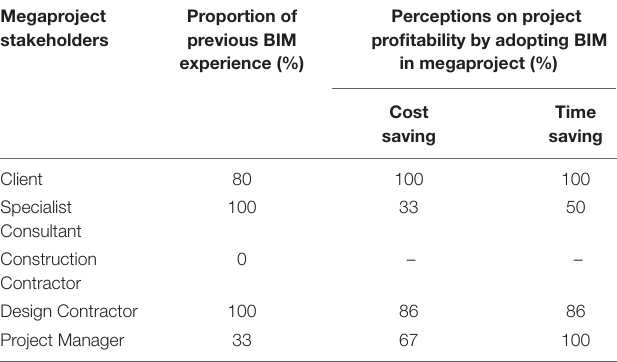
TABLE 7 | Perceptions of capital cost and time savings by